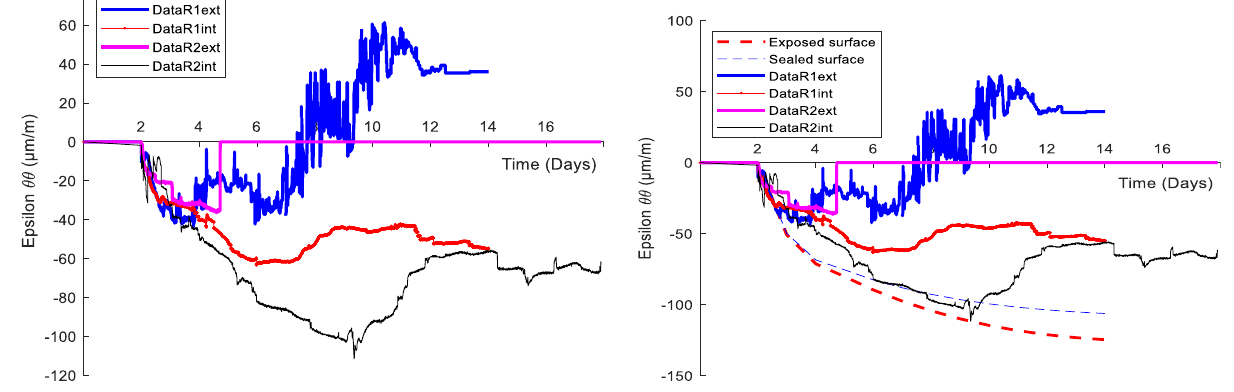
Figure 15: 435 Measured strains ( μ m/m ) . Figure 16: Total strains versus time without relaxation e ff